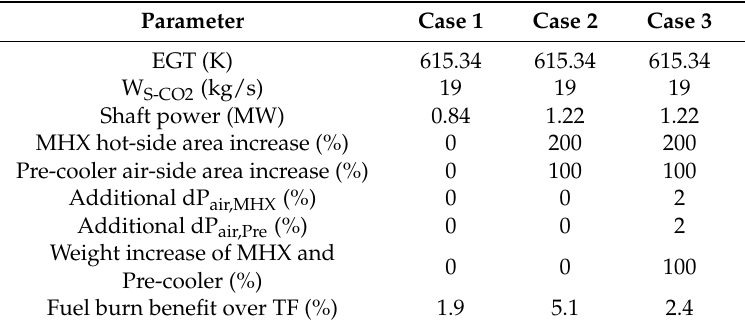
Table 11. Approximate influence of improved design boundaries at